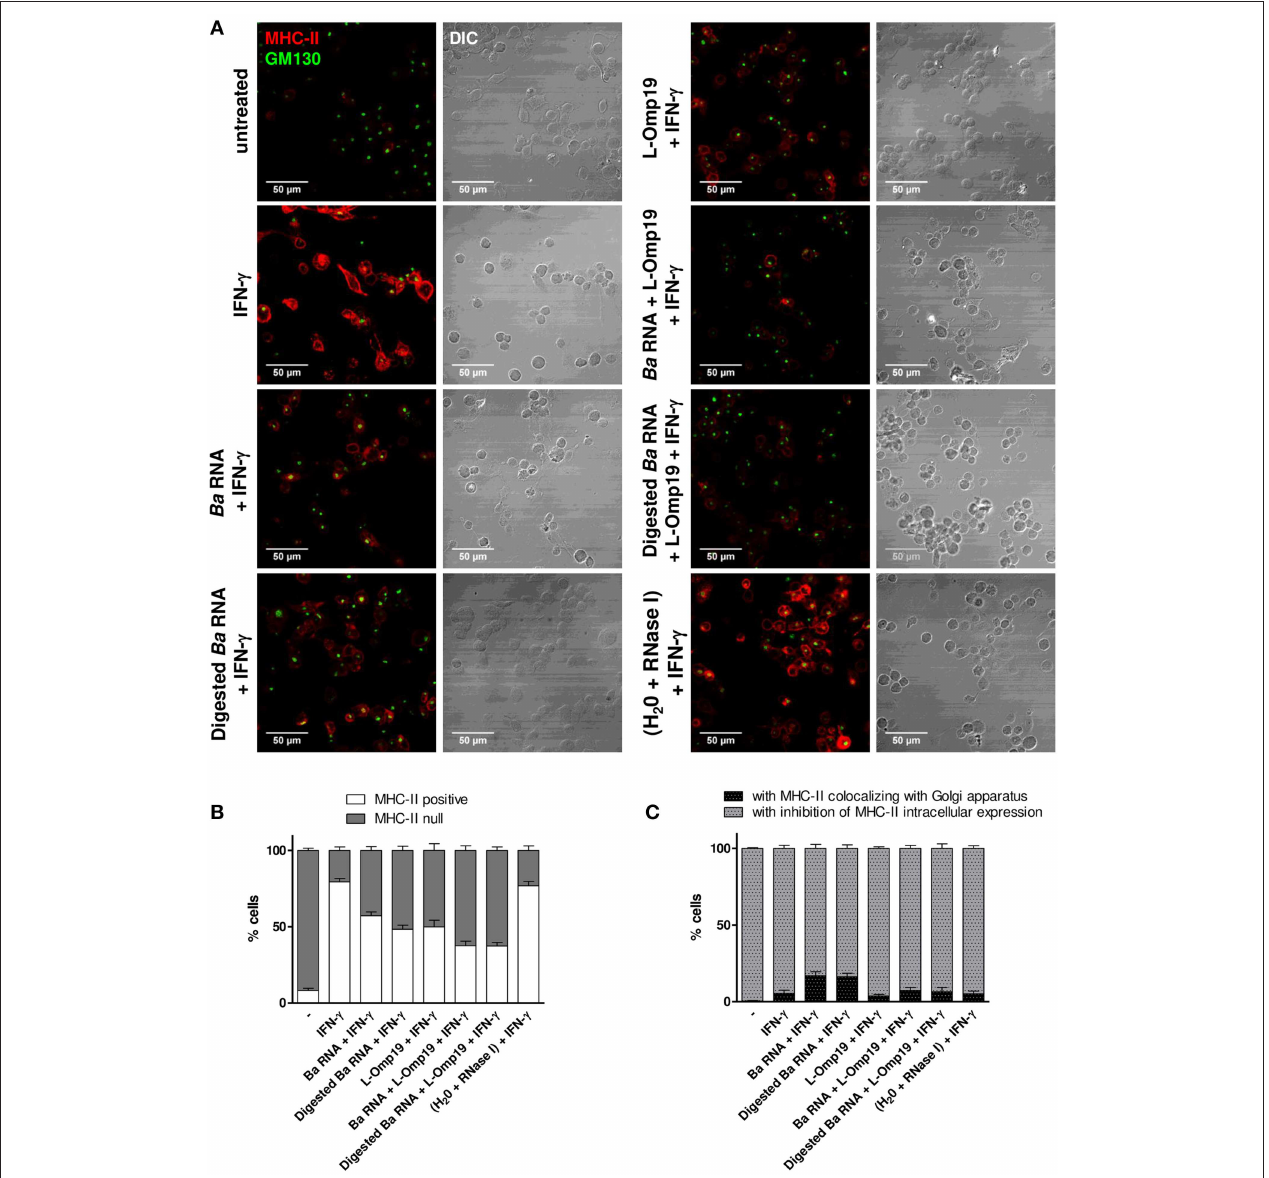
FIGURE 7 | B. abortus RNA and digested B. abortus RNA inhibit MHC-II expression on and inside the cells. (A) Confocal micrographs of THP-1 cells treated with B. abortus RNA (10 µ g/ml), digested B. abortus RNA, L-Omp19 (1 µ g/ml) or their combination in the presence of IFN- γ for 48h. Cells treated with RNase I were used as a control. MHC-II was detected with a primary anti-human MHC-II Ab (L243) followed by Alexa 546-labeled secondary Ab (red). Golgi apparatus was detected using a mAb specific for GM130 followed by Alexa 488-labeled secondary Ab (green). Results are representative of three independent experiments. (B) Quantification of cells expressing MHC-II (MHC-II positive cells) or not (MHC-II null). Data is expressed as the percentage of cells ± SEM of three independent experiments. (C) Quantification of null cells with MHC-II colocalizing with Golgi apparatus or with inhibition of intracellular MHC-II expression. Data is expressed as the percentage of cells ± SEM of three independent experiments. The number of cells counted per experimental group was 200. DIC, differential interference contrast.